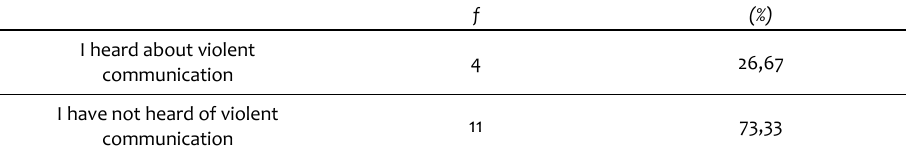
Table 1. Familiarity of students with violent communication before the research I heard about violent communication